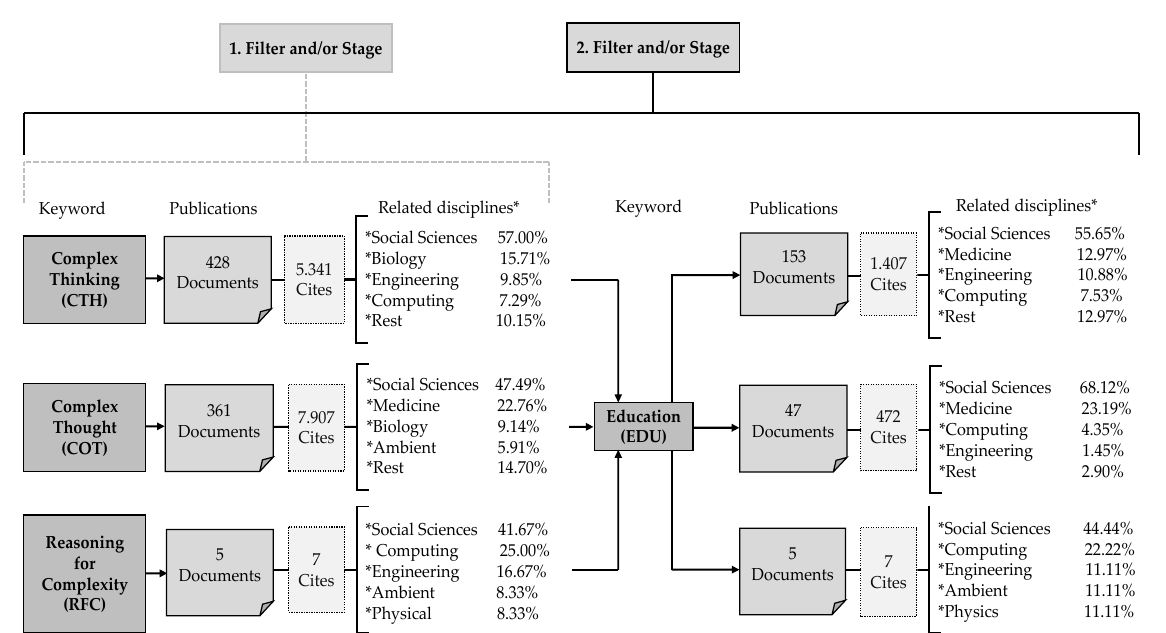
Figure 3. Documents and citations within the field of complex thinking and education. Source: own elaboration based on Scopus (2022).